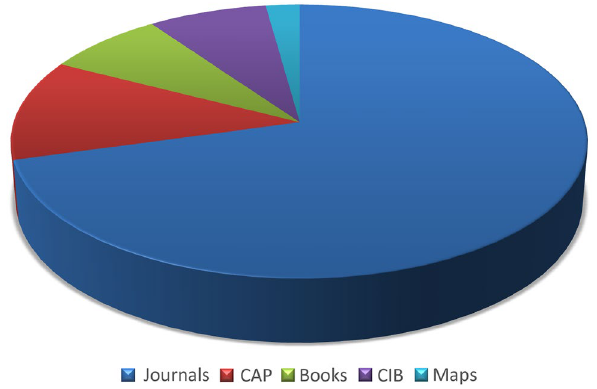
Fig. 5 Summary of cited bibliography. CAP conference abstracts and proceedings (11.96%), CIB chapters in books (7.61).